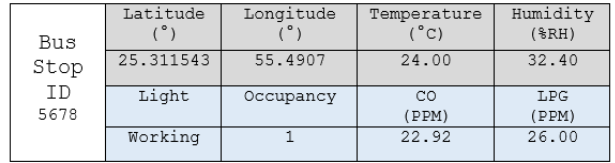
Figure 6. Bus stop data format.